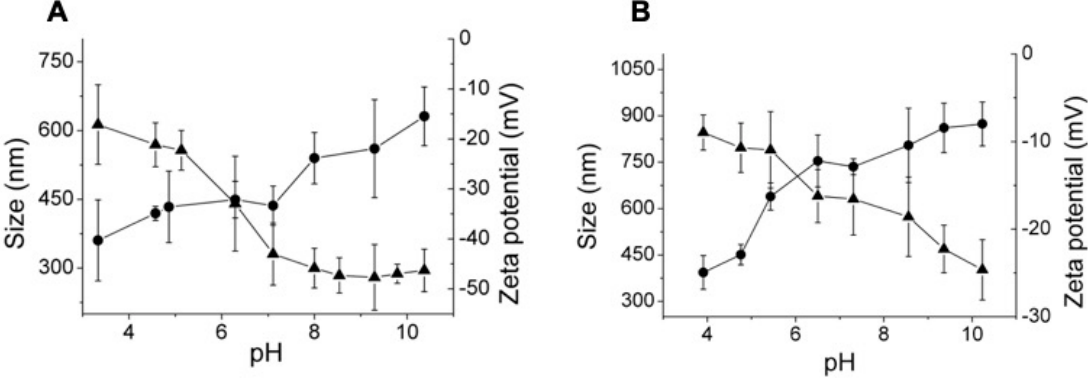
Figure 7. Hydrodynamic diameters ( ● ) and zeta potential ( ▲ ) as a function of external pH for HA nanogels obtained by crosslinking with BDDE with ( A ) high molecular weight and ( B ) low molecular weight HA.